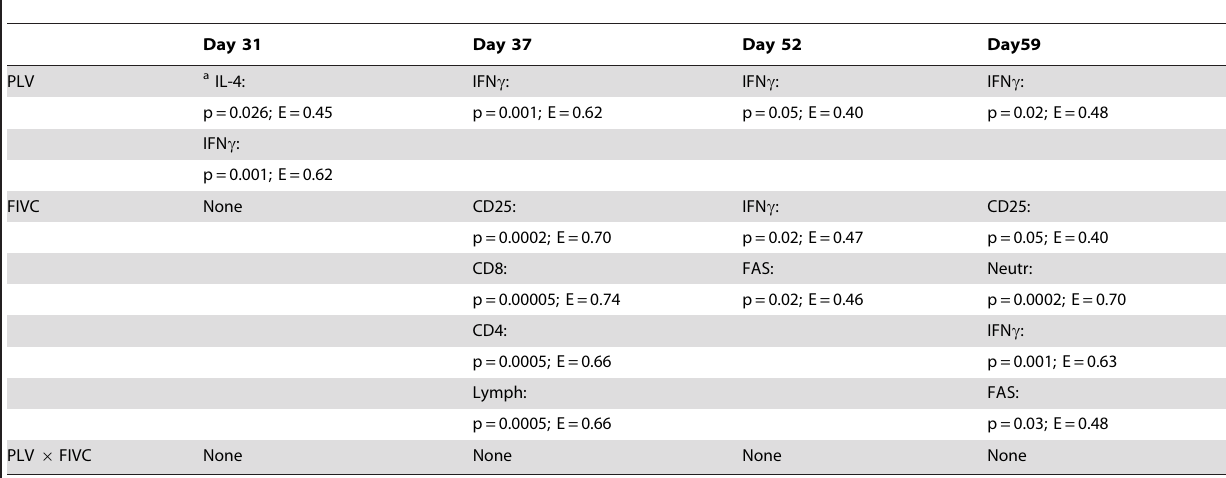
Table 5. Estimated effects (E) and Bonferroni corrected F-based p-values (p) for two-way ANOVA schemes applied to each immunological parameter separately, for each day of